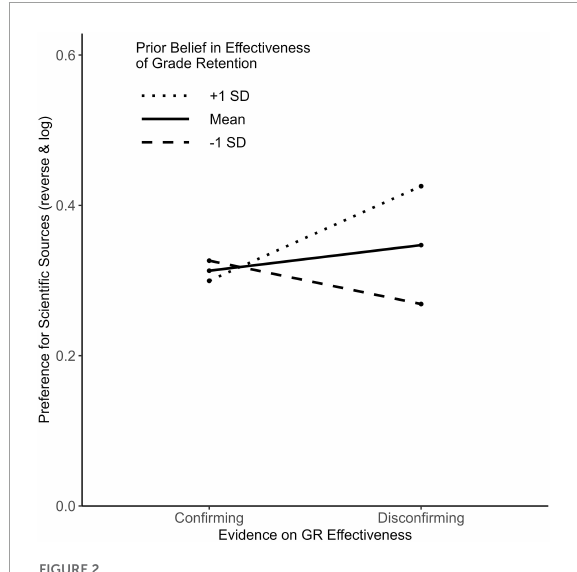
FIGURE2 Preference for scientific soures. Higher values indicate lower source preference ratings due to transformation.